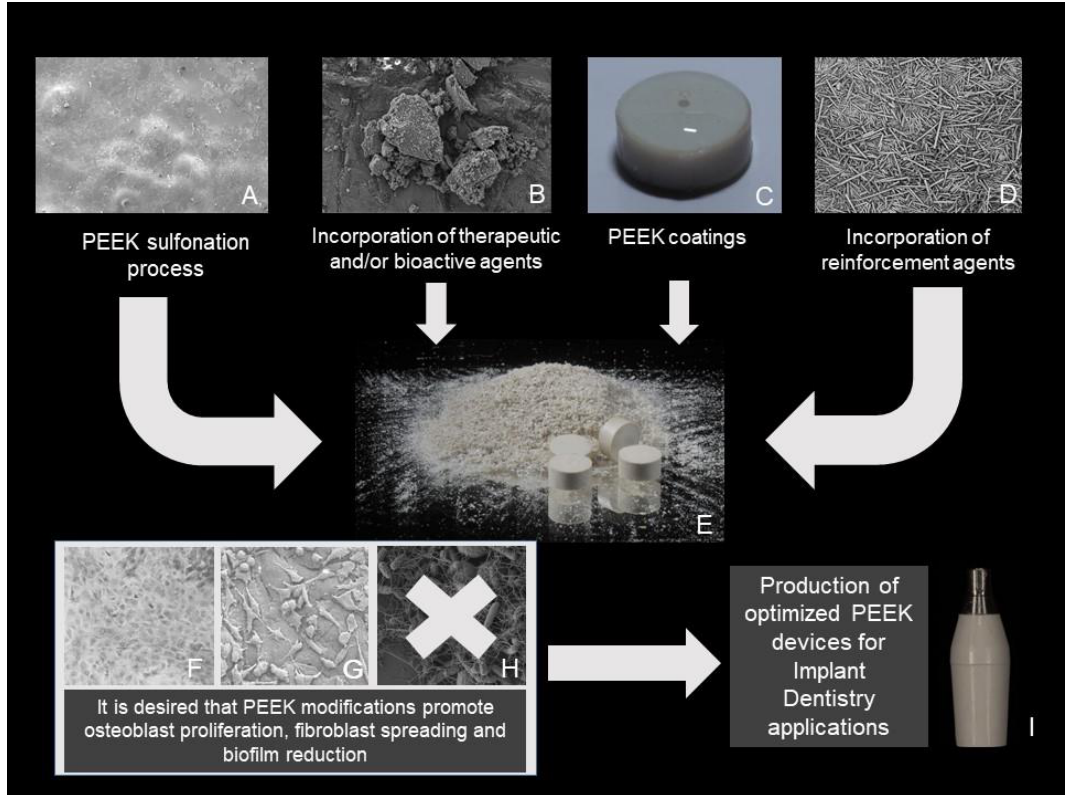
Figure 2. Summary of some available strategies to improve PEEK biological properties. ( A ) SEM image of a sulfonated PEEK membrane; ( B ) SEM image of bioglass particles; ( C ) photography of PEEK coated with adhesive film; ( D ) SEM image of natural amorphous silica fibers; ( E ) photography of PEEK powder and PEEK cylinders manufactured through compression molding; ( F , G ) SEM images of MC3T3 osteoblasts on zirconia surface; L929 fibroblasts on PEEK surface; ( H ) undesired biofilm formation on material surface; ( I ) PEEK provisional abutment (Straumann, Switzerland).